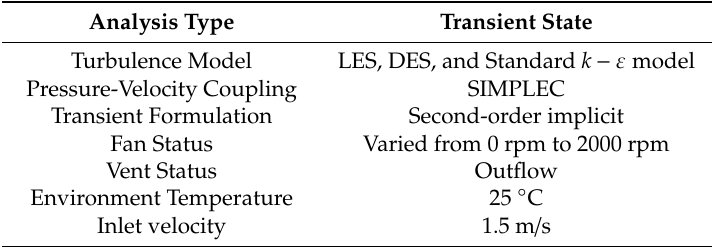
Table 1. CFD (computational fluid dynamics) model